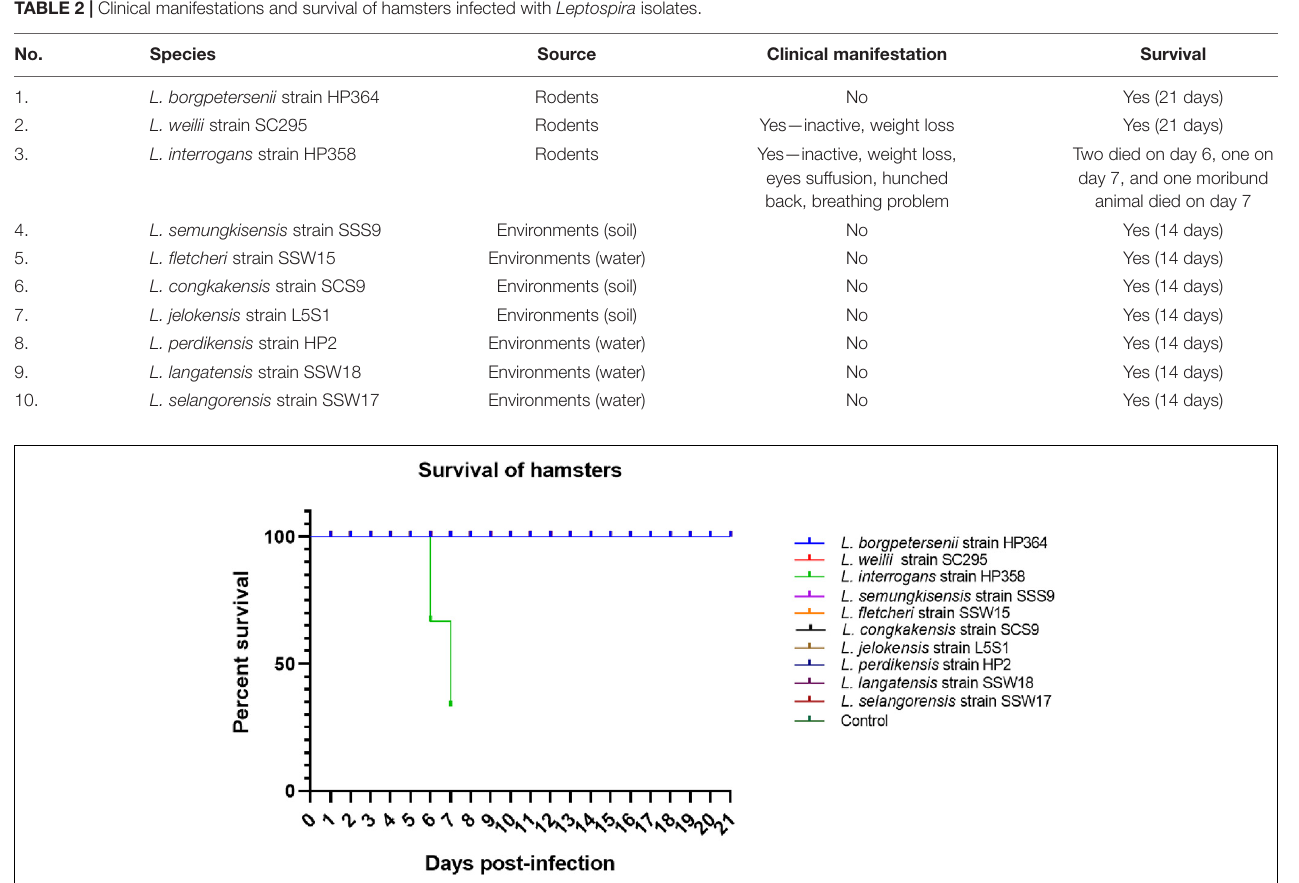
FIGURE 2 | Survival curve. Only L. interrogans strain HP358 caused fatality in infected animals.